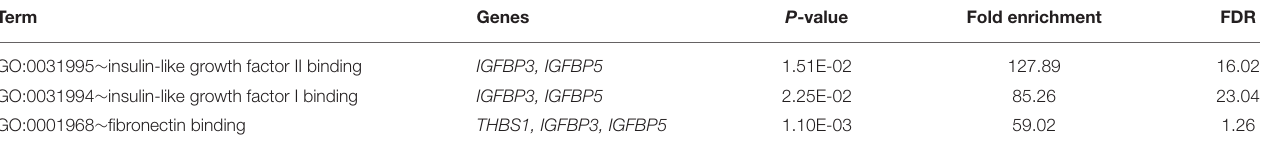
TABLE 3 | Gene ontology analysis for molecular function of genes involved in the ceRNA regulation network in ACC. Term Genes P -value Fold enrichment